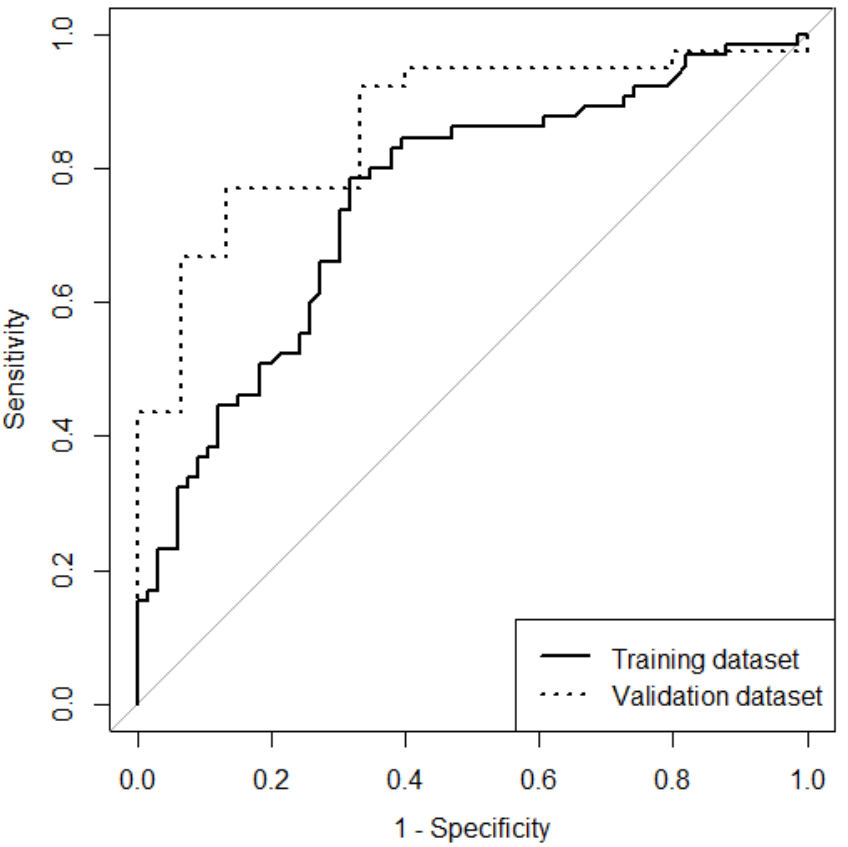
Figure 2. Receiver operating characteristic curve of the training and validation datasets. The nomogram for semantic visualization was developed based on a multivariable logistic regression model. Age and the NIHSS score were the linear predictors used to calculate the functional recovery probability within 3 months after AIS. This prediction was determined by comparing the ‘age’ axis to the ‘points’ scale and by drawing a verti- cal line upward between the two axes; the same process was repeated for the ‘NIHSS’ factor. Summing the ‘Age’ and ‘NIHSS’ points gives rise to the ‘Total Points’ scale, and a vertical line drawn to the ‘functional recovery probability’ axis indicates the estimated functional recovery probability (Figure 3A). For example, a patient aged 60 years (43 points) with an overall NIHSS score of 12 (62 points) receives a total point score of 105. This score corresponded to an estimated probability of 67% for functional recovery (Fig- ure 3B). Total points in this nomogram greater than 85 indicated a 50% likelihood of fa- vorable functional recovery. We judged the performance and calibration of our nomo-